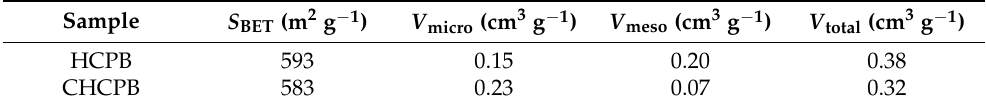
Figure 1. ( a ) Raman spectra and ( b ) XRD patterns of HCPB and CHCPB; ( c ) N 2 adsorption-desorption isothermal curves; and the pore size distribution curves ( d ) of HCPB and CHCPB. Table 1. Porosity parameters of polymer and hard